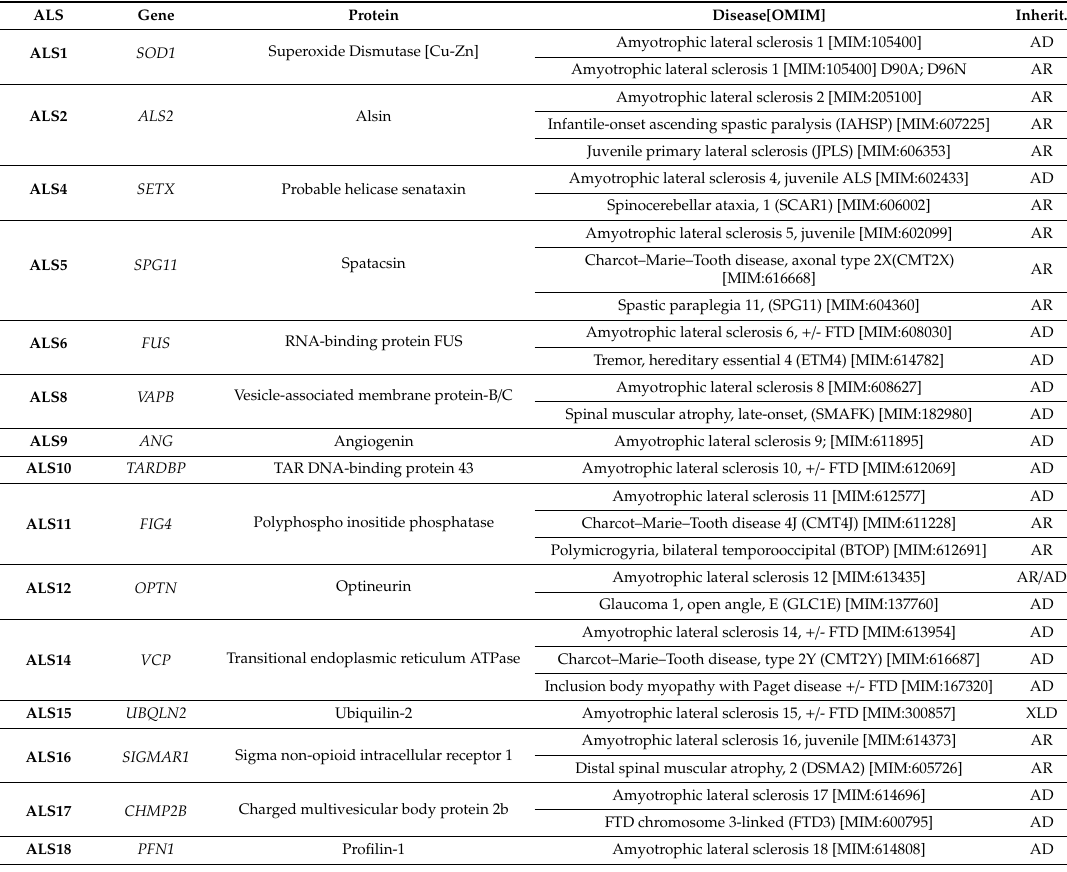
Table 1. Genes analyzed in this